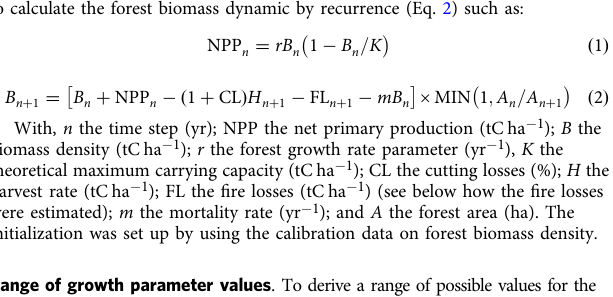
The optimized growth parameters described the relationship between NPP and standing biomass density (B) (Eq. 1) and, together with the other input data, allow to calculate the forest biomass dynamic by recurrence (Eq. 2) such as: Supplementary Table 4). The expansion factors, i.e., the allometric coef fi cients between tree stems and other tree parts, per ecoregion given in Supplementary Table 5, were used when data reported on biomass missed speci fi c tree organs. Equation (1) was fi tted to best reproduce the site measurements in each ecoregion. The r and K parameters of the curve with the smallest residues to the data points were identi fi ed (using the MATLAB function fmincon), under the constraints of r being between 0.01 and 1.00, and K being between 0 and 1000. The agreement of fi t for the fi tted function was calculated. To arrive at a range of r and K values, data were only selectively used for the fi tting of the function. For the minimum values of r and K , only NPP values below the median were used per 0.2 percentile of biomass values. For the maximum values of r and K , only NPP values above the median were used per 0.2 percentile of standing